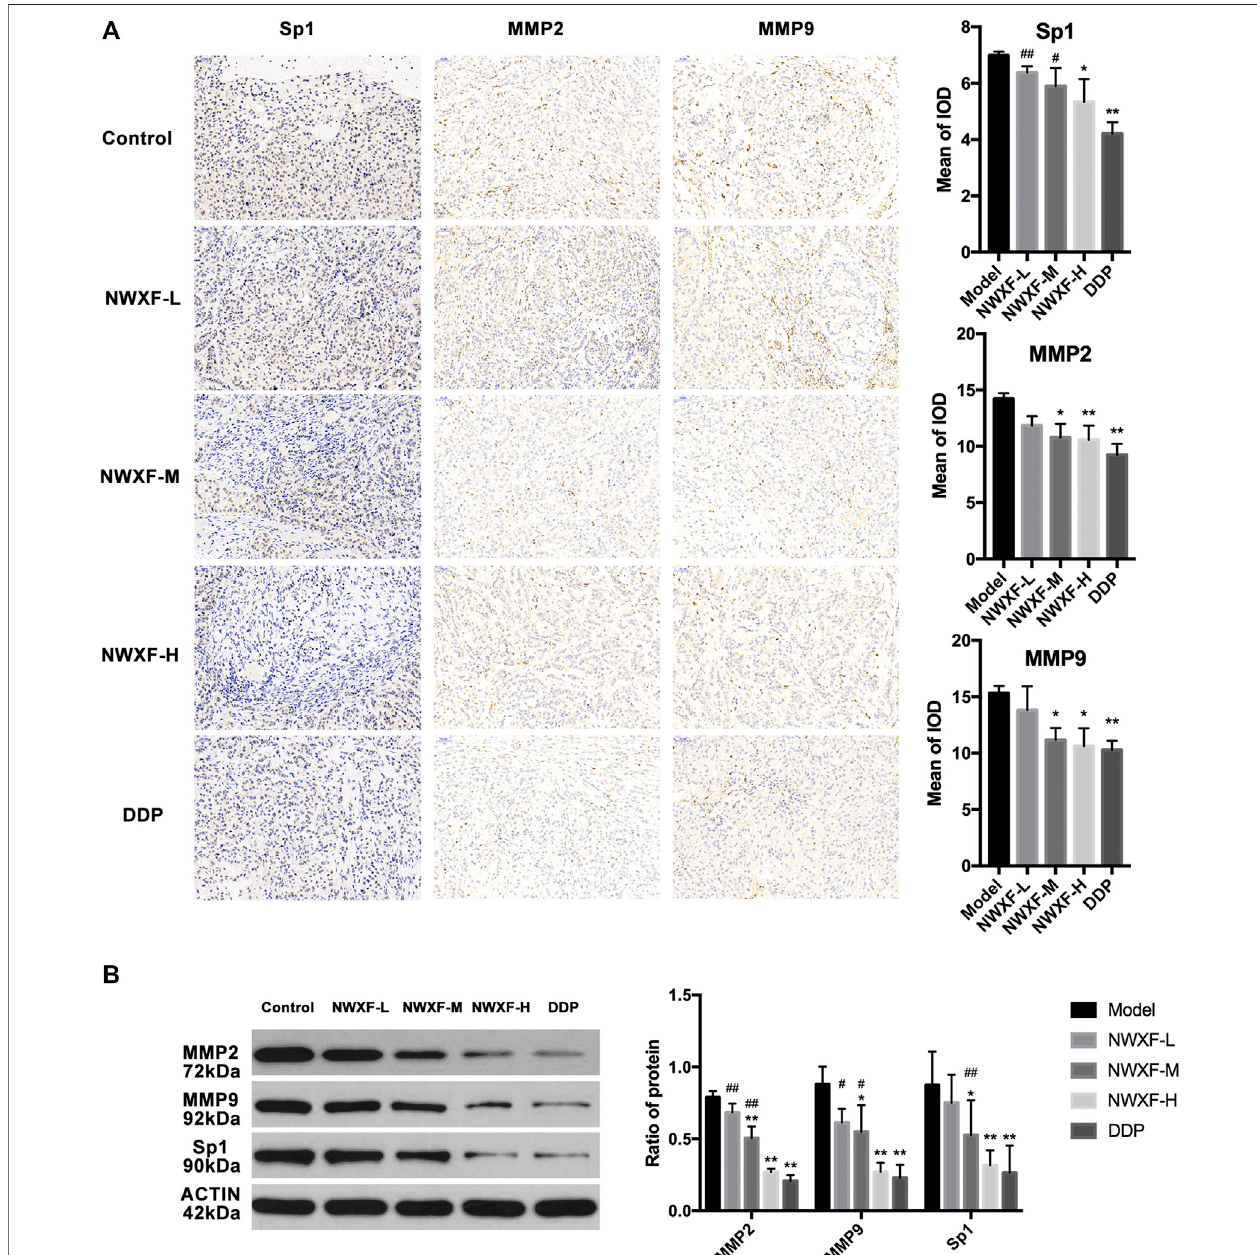
FIGURE 4 | NWXF inhibits expression of Sp1, MMP2, and MMP9 in transplanted tumor. (A) Immunohistochemical detection of Sp1, MMP2, and MMP9 protein levelsinorthotopicsite(imagemagni fi cation: × 200).ThemeanofiodwereanalyzedbyImage-ProPlus6.0software. (B) WesternblotanalysisofSp1,MMP2,andMMP9 expression in xenograft. p p < 0.05, pp p < 0.01 vs. the control group. # p < 0.05, ## p < 0.01 vs. the DDP